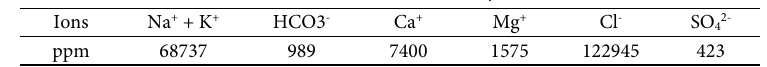
Table 1. Reservoir brine analysis Table 2: Reservoir brine analysis